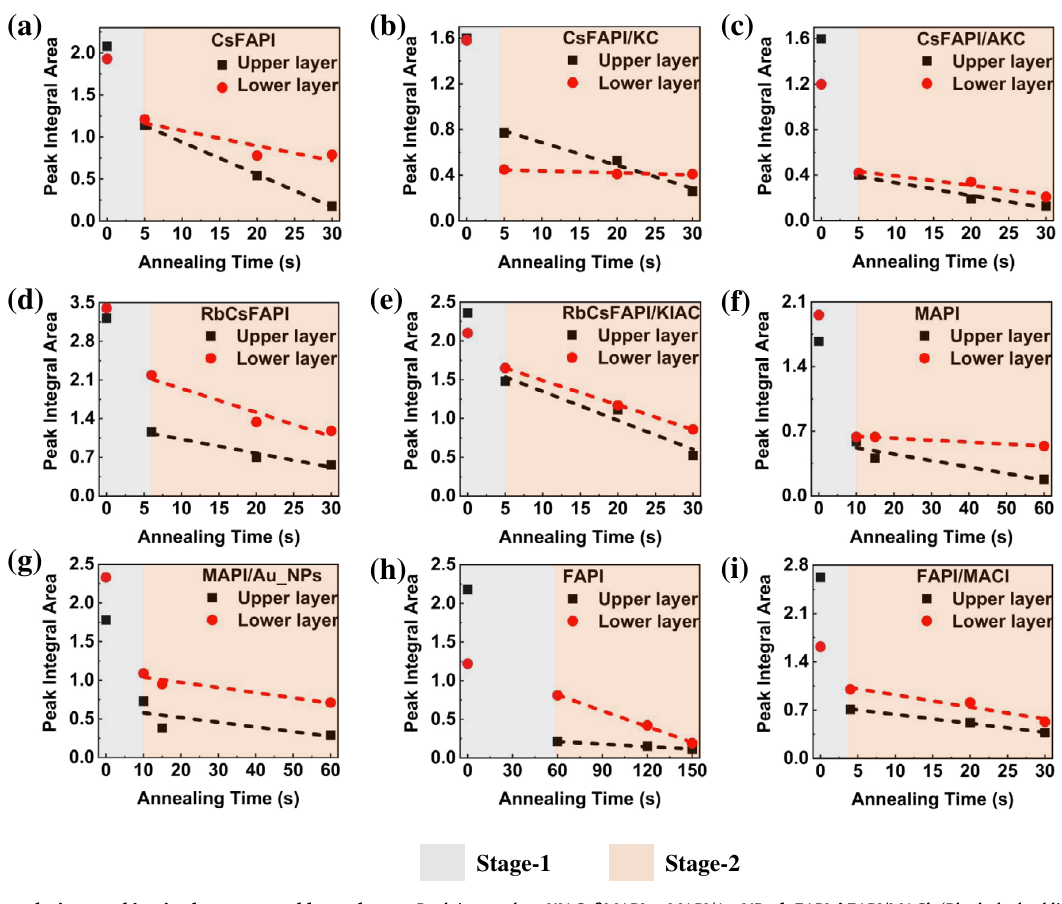
KIAC. f MAPI. g MAPI/Au_NPs. h FAPI. i FAPI/MACl.(Blackdashed line: linear fi t line of upper layer in stage-2; Red dashed line: linear fi t line of lower layer in stage-2). Source data are provided as a Source Data fi le.